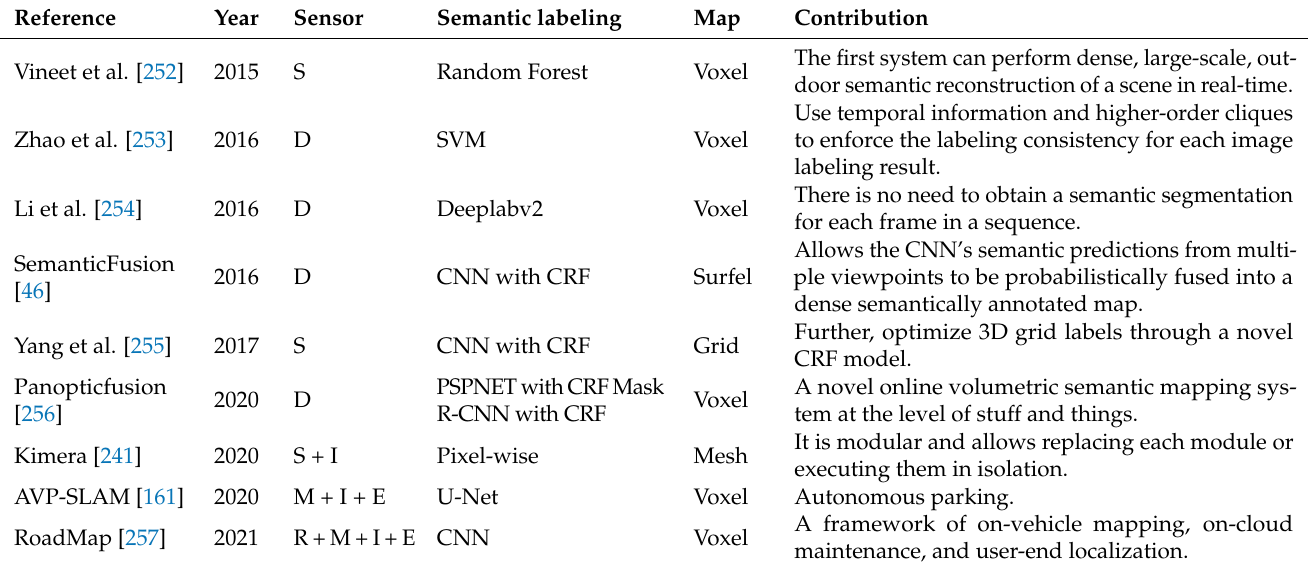
Table 13. Part of the excellent semantic mapping